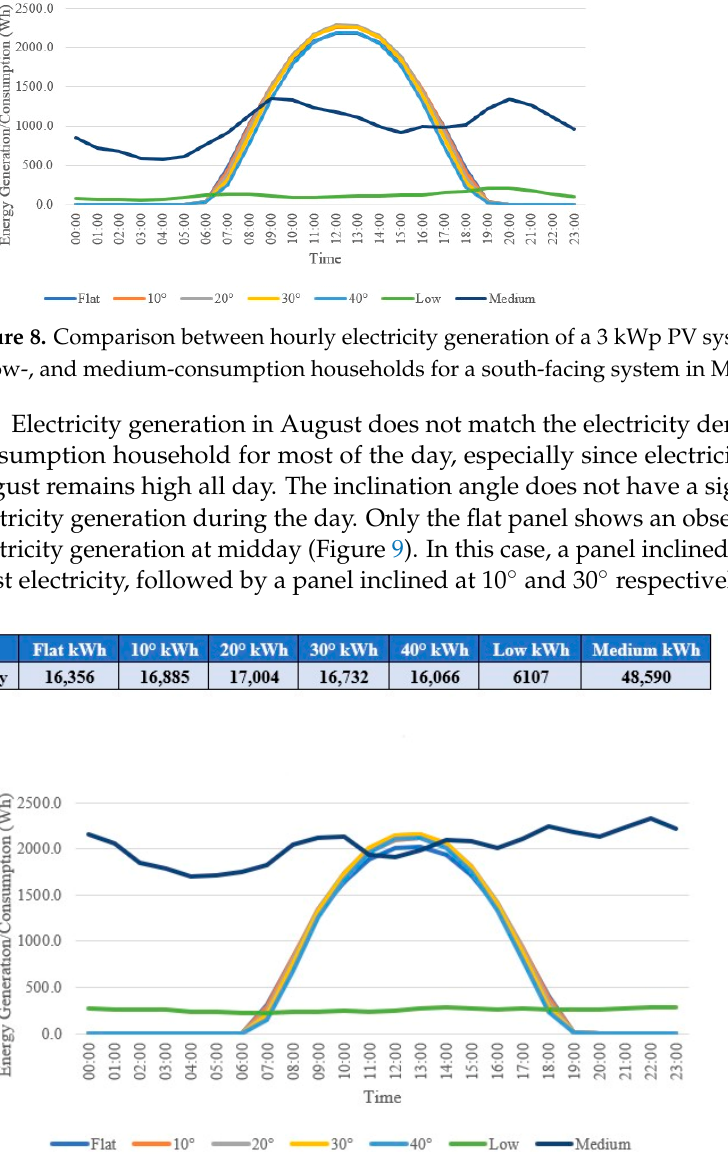
Figure 9. Comparison between hourly electricity generation of a 3 kWp PV system and the patterns of low-, and medium-consumption households for a south-facing system in August.